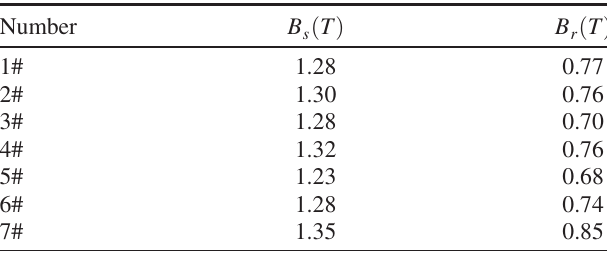
TABLE IV. Saturation and remanent inductions of the seven magnetic cores from DC B-H loops at 80 . 0 A = m. It should be mentioned that the saturation induction will approach 1.56 T if the magnetic cores are tested at 800 . 0 A = m condition.